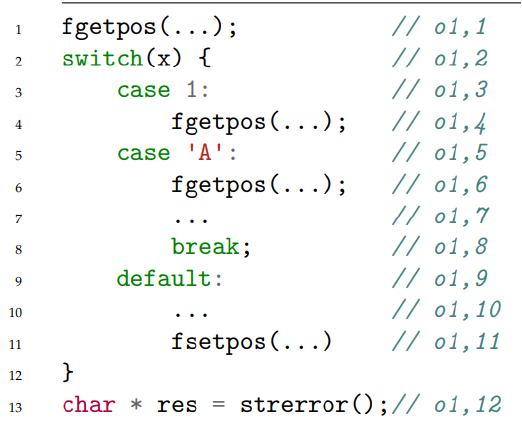
Figure 5. Pseudocode showing the process of breaking relationships.